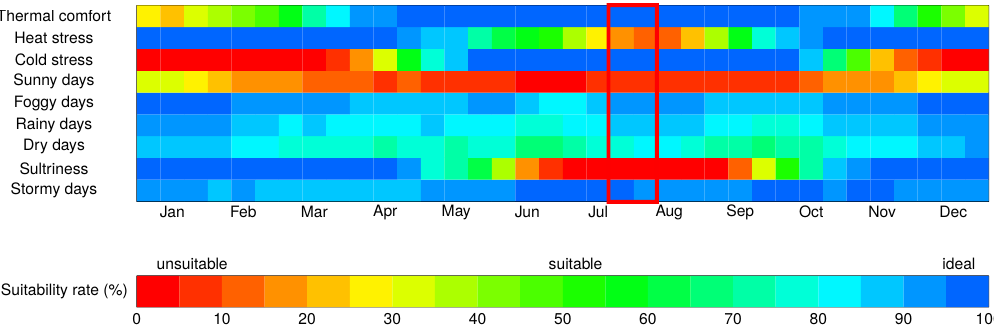
Figure 8. “Climate-Tourism/Transfer-Information Scheme” (CTIS) for Tokyo. The red lined box highlights the scheduled time for the Olympic Games 2020. The suitability rate defines the suitability of each category for tourists per an approximate decadal